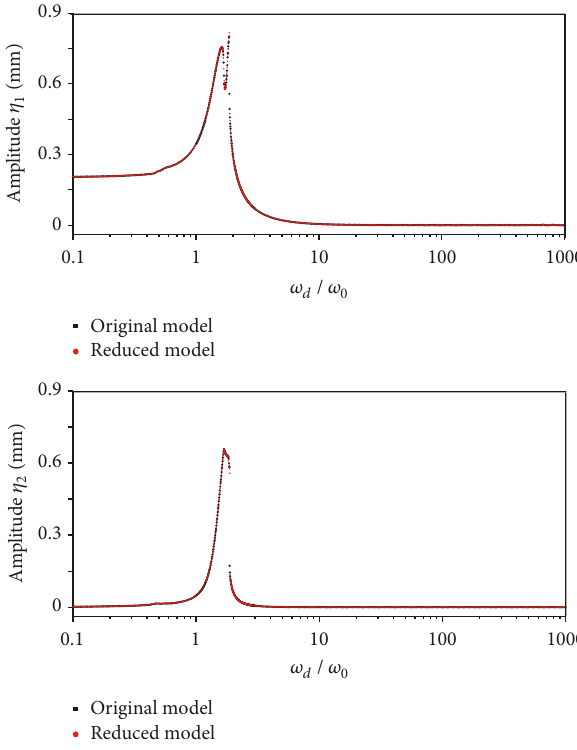
Figure 5: Comparison of the amplitude-frequency response between original model and reduced model ( 𝑚 = 1 , 𝑛 = 5 ; Ω =0.005; 𝐹 = 500 N). 0